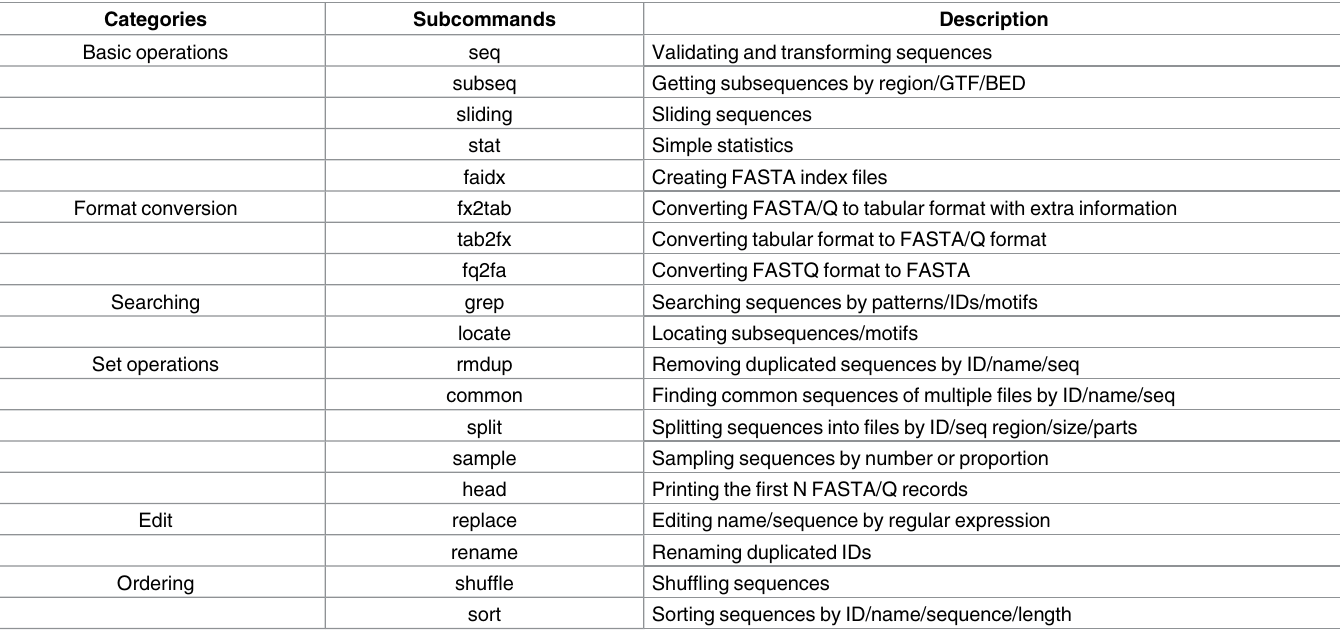
Table 1. Subcommands of SeqKit